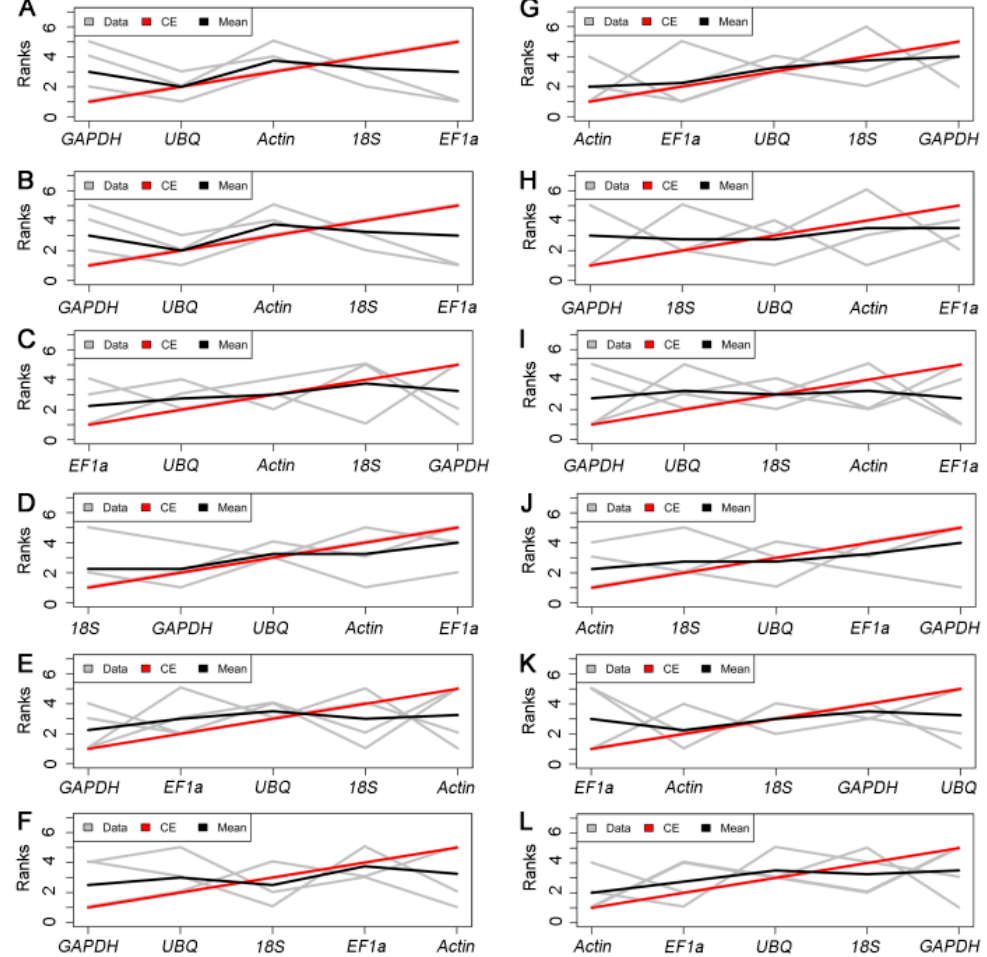
Figure 6. Rank aggregation of gene lists using the Monte Carlo algorithm. Visual representation of rank aggregation using Monte Carlo algorithm with the Spearman foot rule distances: ( A – F ) different treatments for cotyledon (( A ) cold-treated; ( B ) HT-treated; ( C ) ABA-treated; ( D ) NaCl-treated; ( E ) PEG-treated; and ( F ) total); and ( G – L ) different treatments for roots (( G ) cold-treated; ( H ) HT-treated; ( I ) ABA-treated; ( J ) NaCl-treated; ( K ) PEG-treated; and ( L ) total). Different lines in the plot represent the following: gray lines, stability measurement; black lines, rank position; and red lines, model computed by the Monte Carlo algorithm. Abbreviations: HT: High Temperature treatment; Cold: Cold treatment; ABA: Abscisic Acid treatment; NaCl: Sodium Chloride treatment; PEG: Polyethylene Glycol treatment. Table 5. Best combination of HKGs based on the geNorm and RankAggreg programs. Different